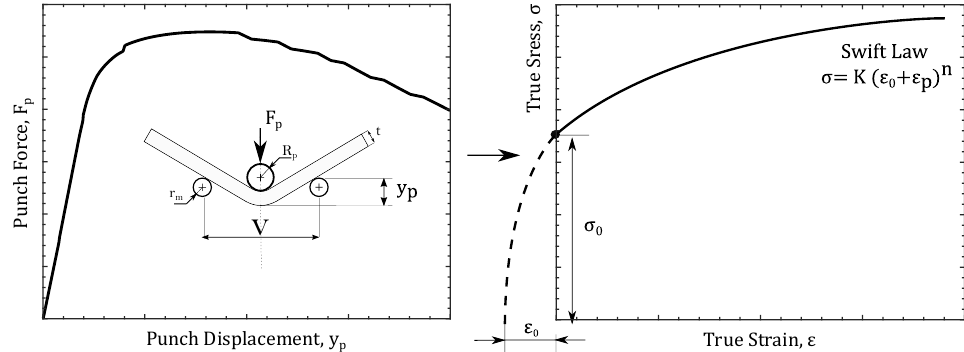
Figure 3. Schematic illustration of the three-point bending test and definition of the main objectives for problem